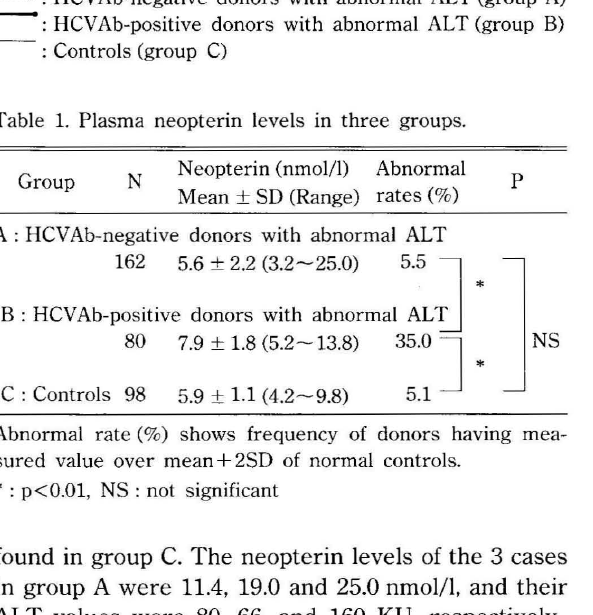
Table 1. Plasma neopterin levels in three